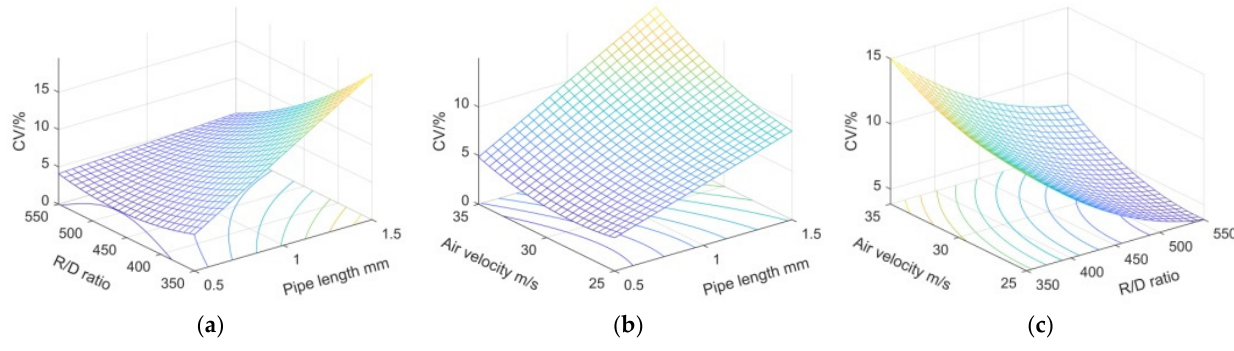
Figure 11. Influence of factor interaction on the coefficient of variation. ( a ) The interaction of the bending diameter ratio of the elbow and the length of the bellows on the coefficient of variation; ( b ) The interaction of the bending diameter ratio and the airflow velocity of the elbow on the variation system; ( c ) The interaction of the air velocity and the length of the bellows on the coefficient of variation.